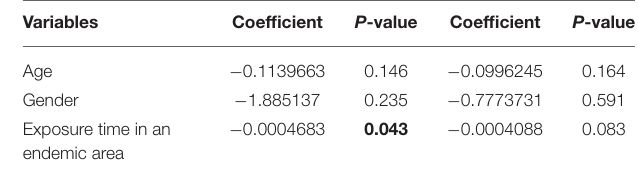
TABLE 2 | Spearman rank correlations between age, gender, IFN- γ , TNF- α , IL-10, IL-17A, ratio IFN- γ /IL-10, and exposure time in the infection place less or equal -and longer- than 90 days.